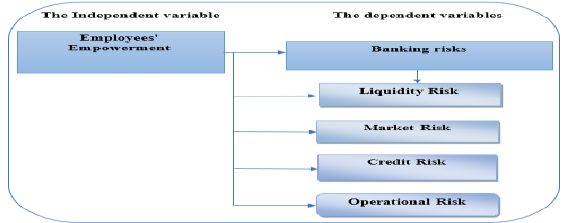
Figure Error! No text of specified style in document.: Model of the study